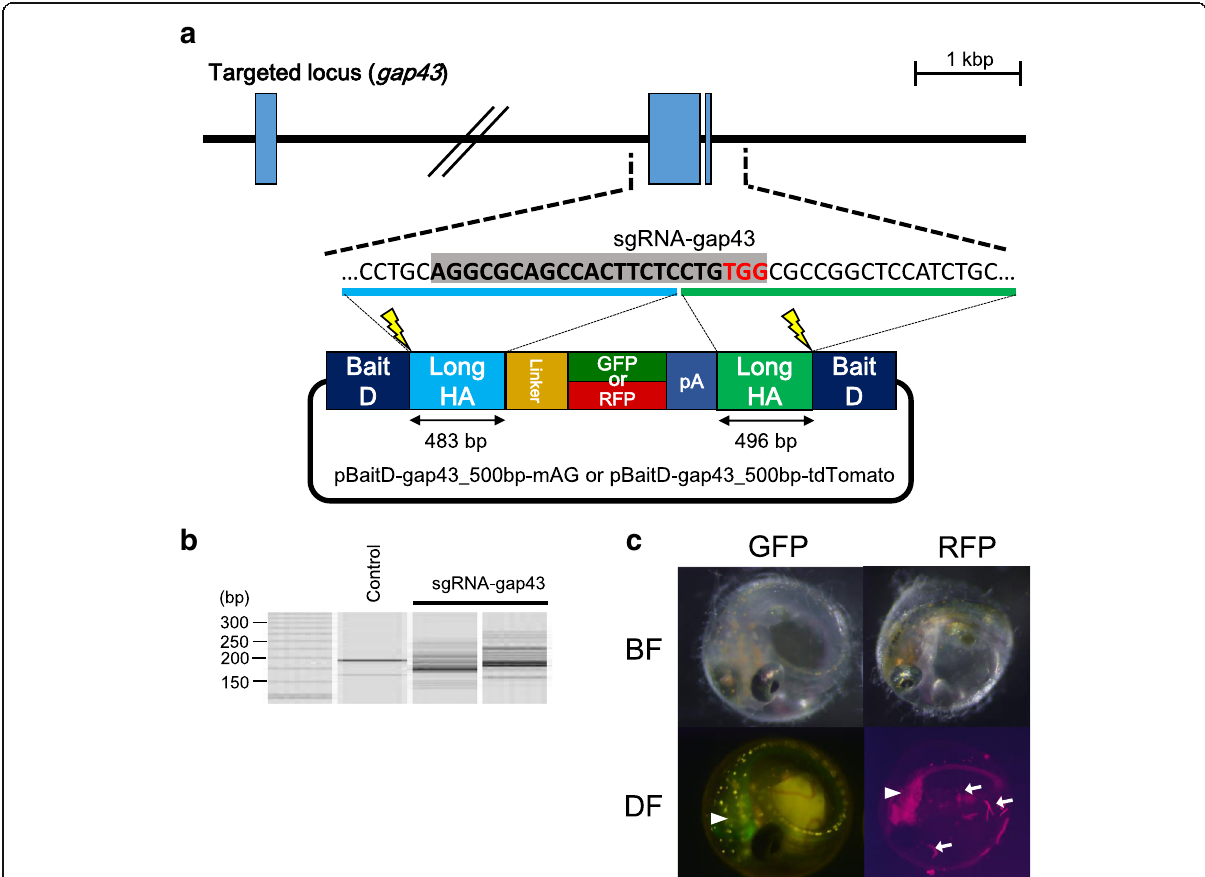
Fig. 3 Targeted gene integration of GFP or RFP constructs containing BaitD into the gap43 locus. (a) Design of sgRNA and homology arms to target the second exon of gap43 gene (Ensembl transcript number ENSORLT00000015837). The donor plasmids contain two BaitD sequences, upstream and downstream homology arms, and monomeric Azami-Green (mAG; as GFP) or tandem-dimer-Tomato (tdTomato; as RFP) with a N- terminal linker and a SV40 polyA signal (pA). The upstream or downstream homology arms (483 or 496 bp) for the donor plasmids are shown in boxes with light blue or green color, respectively. (b) The genome-editing activity by the sgRNA targeting to the gap43 locus (sgRNA-gap43), which was investigated using the heteroduplex mobility assay (HMA) of embryos injected with a mixture containing 100 ng/ μ L of Cas9 mRNA and 50 ng/ μ L of sgRNA-gap43. Control shows the result from an embryo without injection. (c) GFP and RFP expression in the injected embryos at 4 days post fertilization (dpf). Embryos injected with the donor vectors expressed either GFP or RFP in their central nervous system (CNS). White arrowheads show fluorescence in the CNS, while white arrows show autofluorescence of bacteria on the surface of the egg membrane